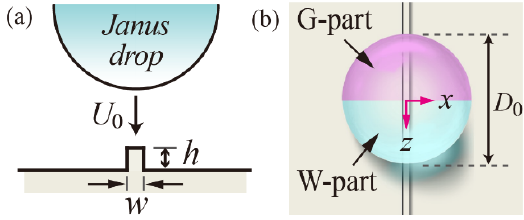
Figure 1. ( a ) Schematic of an impinging Janus drop upon non-wettable solid surfaces decorated with a rectangular ridge at the initial diameter D 0 and impact velocity U 0 . The basic size of the ridge is controlled to the height of h/D 0 = 0.2 and width of w/D 0 = 0.05. ( b ) Janus drops contain two phases of W- (water) and G-parts (glycerin/water mixture) that share a common interface perpendicular to the solid surface.